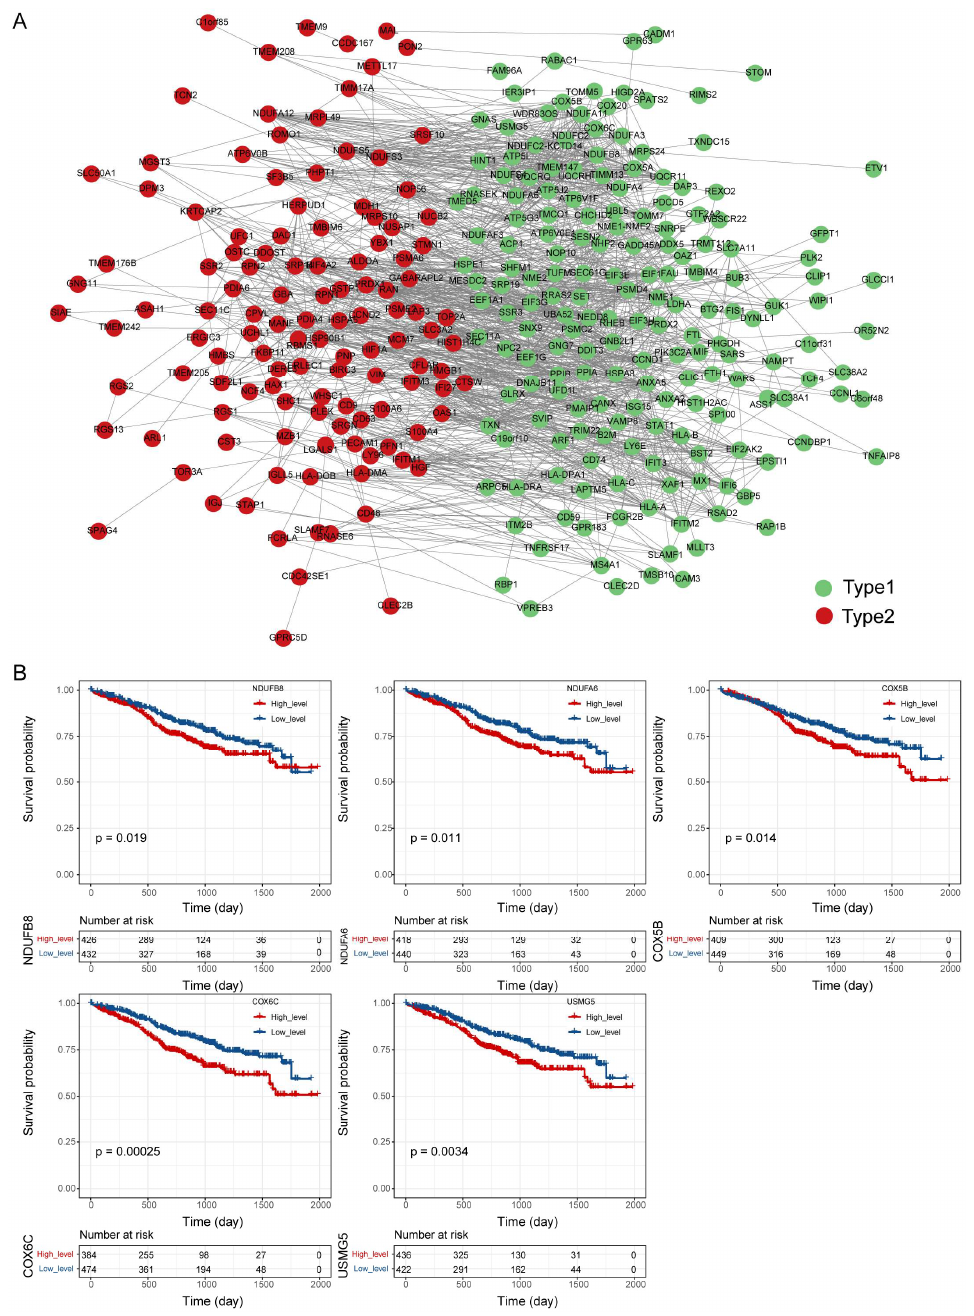
Figure 6. Protein-protein interaction network of DEGs in different cell types and identification of hub genes related to the prognosis of MM ( A ). Protein-protein interaction network of DEGs in Type I and Type II. ( B ). Kaplan–Meier survival curves of MM patients with different expression levels of NDUFB8, NDUFA6, COX5B, COX6C, and